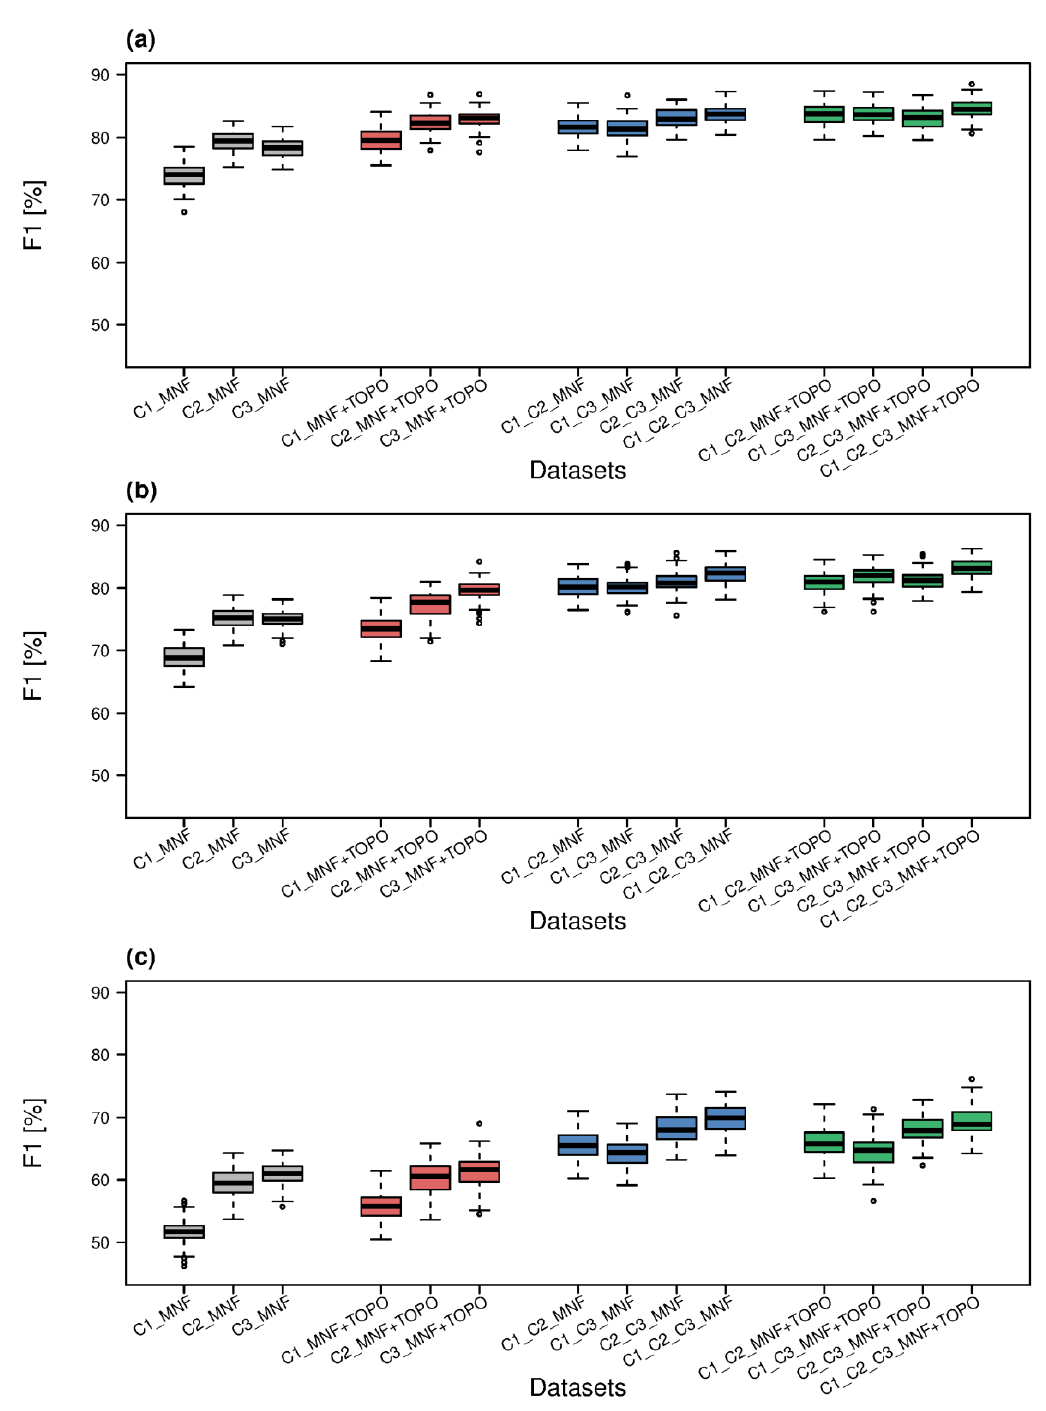
Figure 4. F1 classification accuracies for all datasets in three campaigns calculated for habitat: code 6210 ( a ); code 6410 ( b ) and code 6510 ( c ) (C1, C2, C3—campaign number, MNF—minimum noise fraction, TOPO—topographic indices).